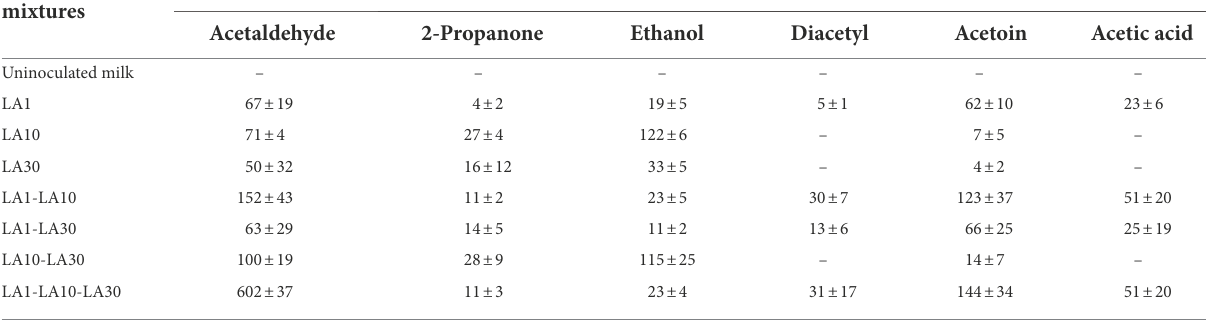
TABLE 5 Relative abundance of the volatile compounds produced and quantified during growth in milk at 32 ° C for 48 h of L. lactis subsp. lactis LA1, L. cremoris subsp. cremoris LA10, and L. plantarum LA30, each incubated alone or in combination. Strain–strain